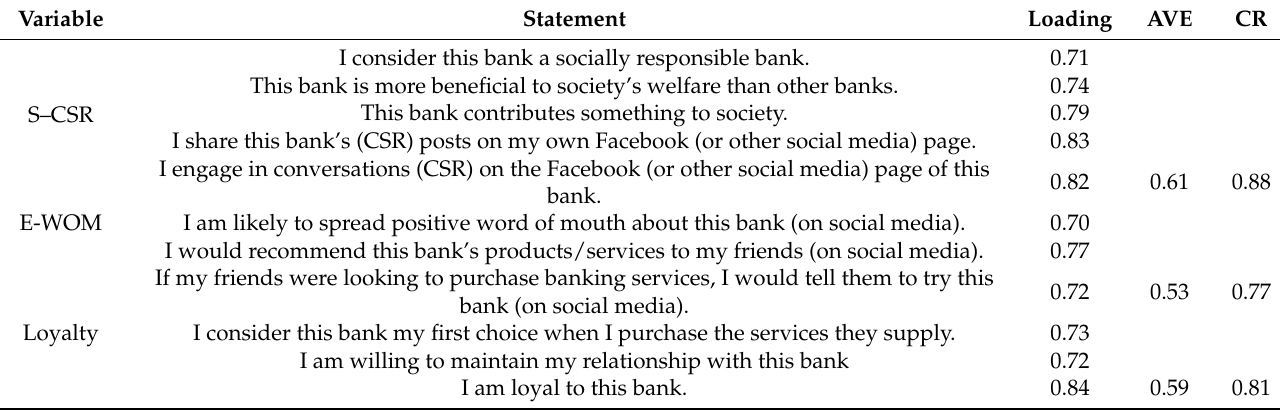
Table 2. Factor loading, convergent validity, and reliability